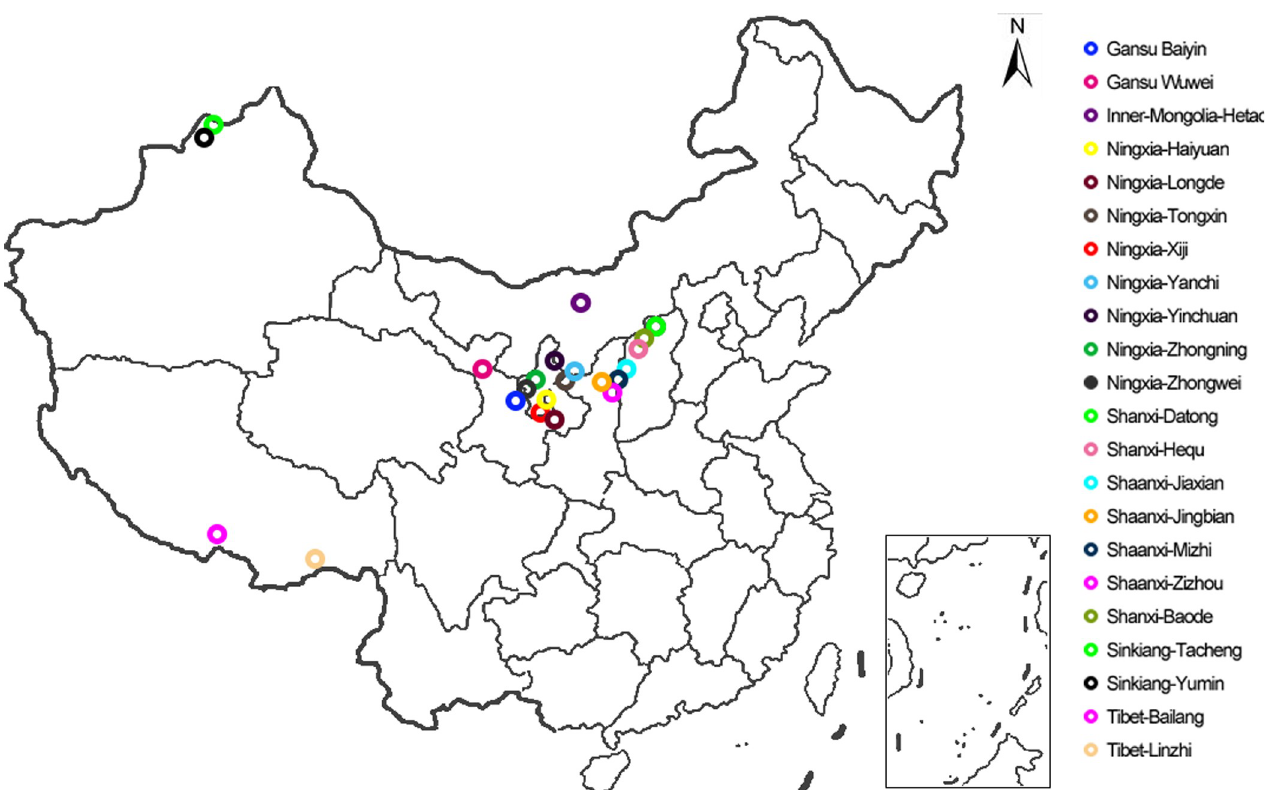
Fig 1. Location of the Lou onion accessions evaluated in this study. (Map sources:OSGeo China). Different colors marked different sampling locations.